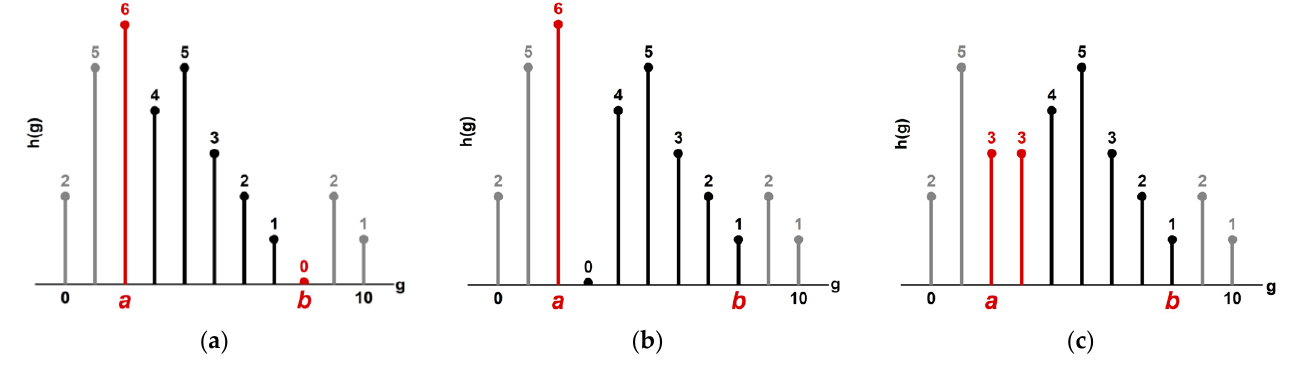
Figure 1. Histogram embedding in histogram shifting scheme; ( a ) original histogram; ( b ) shifted histogram; ( c ) histogram with concealed data.